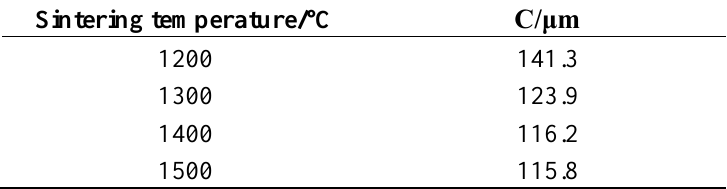
Table 1. The crack lengths from each corner of the indent to the tip of the corresponding crack of the TiB 2 –5 wt% (Fe–Ni–Ti–Al) composites sintered at different